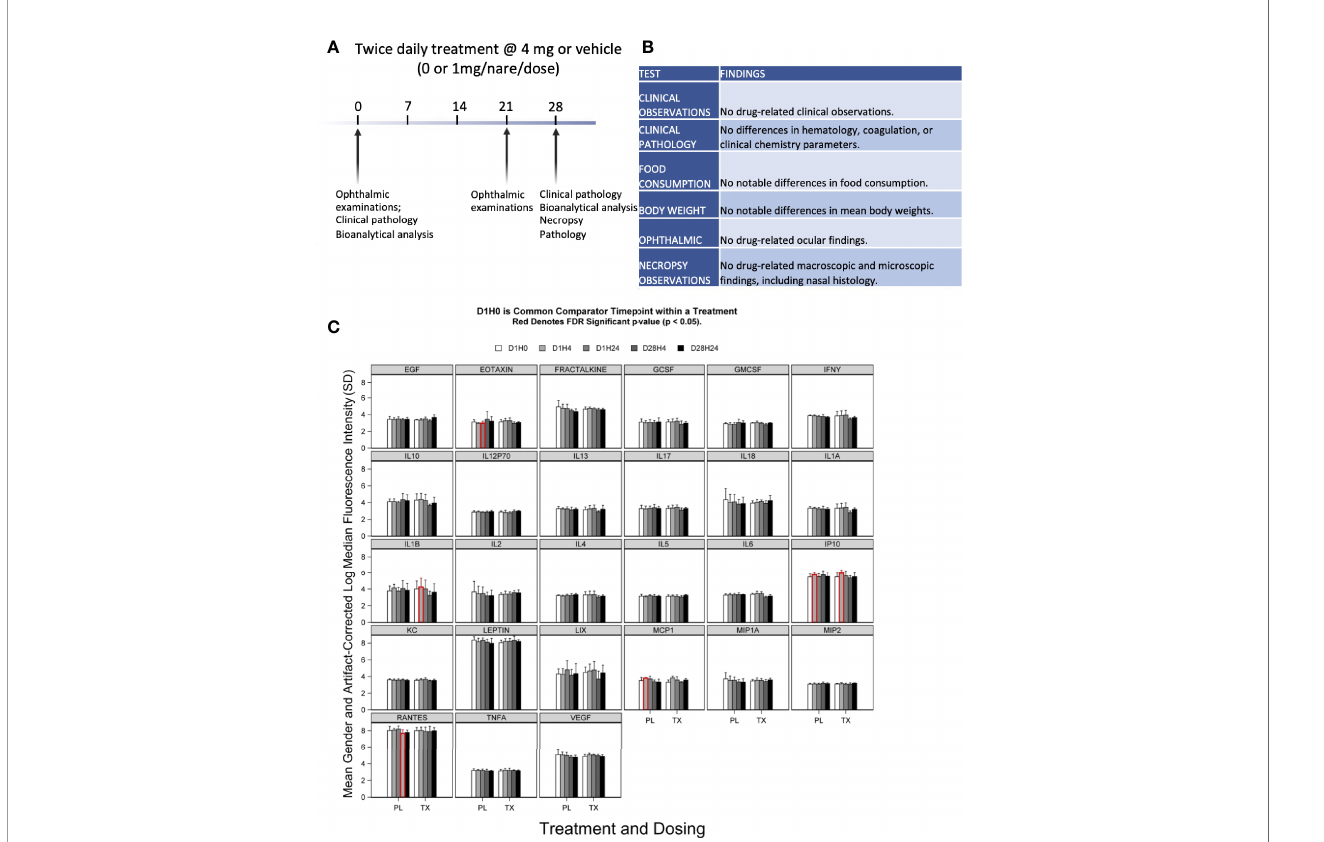
FIGURE 5 | Preclinical toxicity of 28-day treatment with anti-SARS-CoV-2 RBD IgY in rats. (A) Study design. (B) Summary of fi ndings. (C) Serum levels of 27 cytokines over time in rats treated with IgY (Tx) or vehicle/placebo (PL). Data are provided for Day 1 before treatment (D1H0); Day 1, 4 hours after the treatment (D1H4); 24 hours after the two treatments, 6 hours apart, at 24 hours after the fi rst treatment (D1H24); 28 days of twice-daily treatments and 4 hours of the treatment of that day (D28H4); and 28 days of twice-daily treatments and 24 hours of the treatment of that day (D28H24). Red indicates a statistical difference with a false discovery rate (FDR) signi fi cant p-value (p <